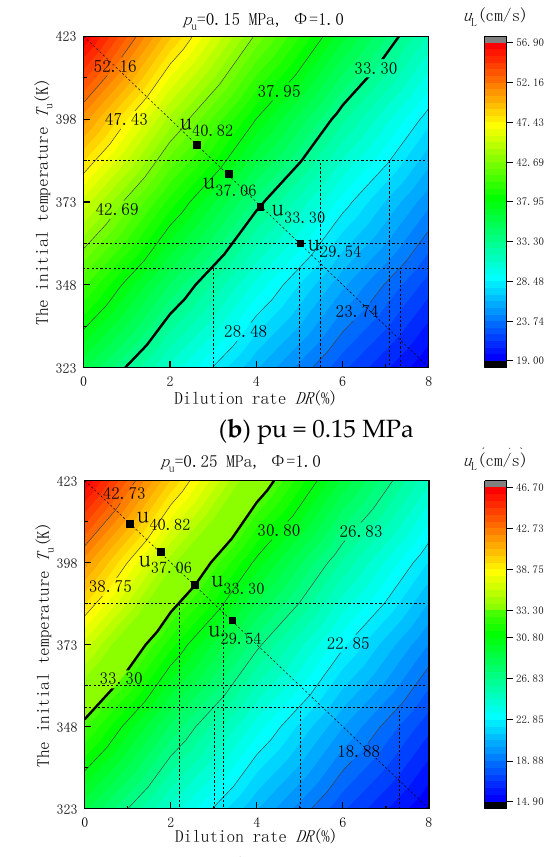
0.08 Figure 11. Equivalent variation of u L corresponding to the initial condition change with Pu.